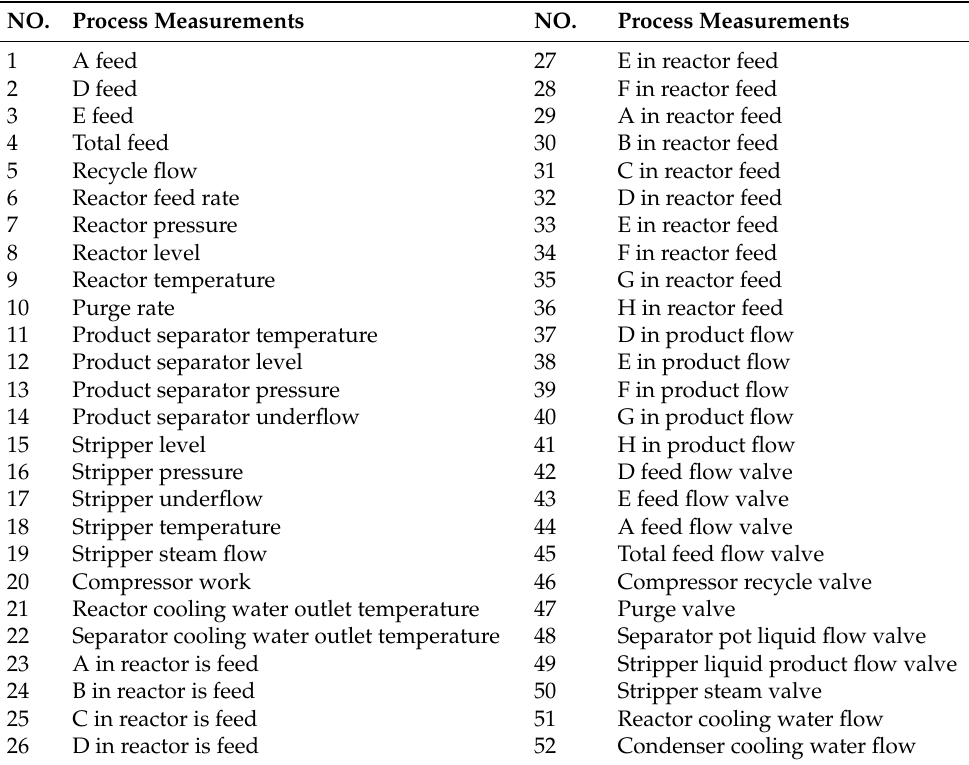
Table 2. Measured and manipulated